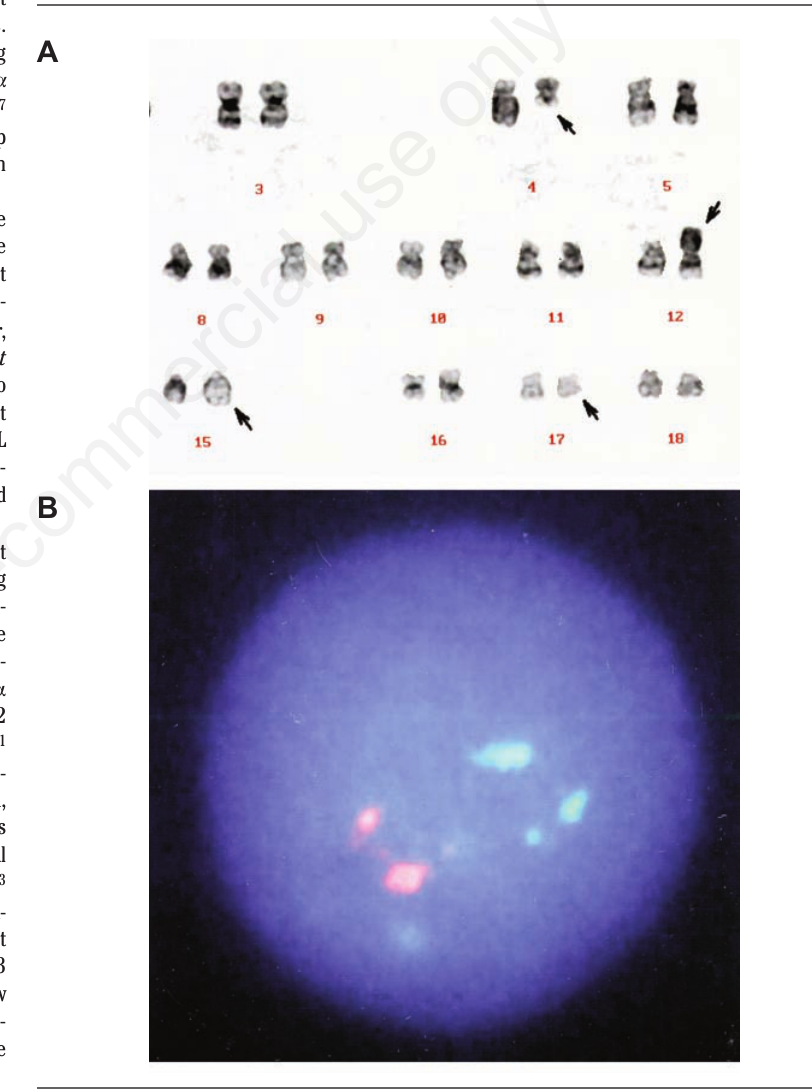
Figure 2. A) G-banded karyotype of the bone marrow cells showing t(4;12)(q21;p11) and t(15;17)(q22;q21). Arrows indicate the derivative chromosomes. B) FISH analysis with PML/RAR -specific probes showing two orange (PML) and two green (RAR No PML/RAR fusion signal (which should appear yellow) was α α